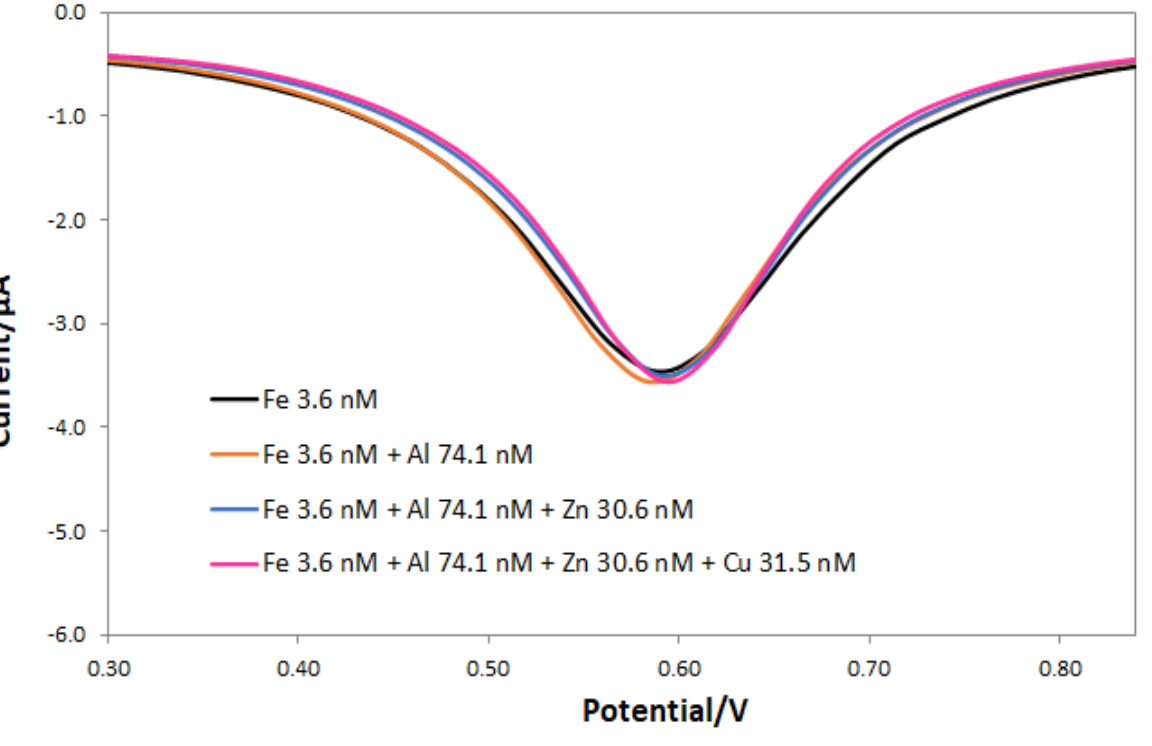
Figure 6. DPV plot obtained on the gold working electrode functionalized with DFO after immersion in 1) solution of Fe(III) 3.6 nM at pH 1 (black line), 2) solution of Fe(III) 3.6 nM and Al(III) 74.1 nM at pH 1 (orange line), 3) solution of Fe(III) 3.6 nM, Al(III) 74.1 nM, and Zn(II) 30.6 nM at pH 1 (blue line), 4) solution of Fe(III) 3.6 nM, Al(III) 74.1 nM, Zn 30.6 nM and Cu(II) 31.5 nM at pH 1 (pink line); DPV measurements were performed in 0.1M acetate buffer at pH 3.5 containing 0.1M NaClO 4 as a supporting electrolyte. Electrochemical conditions were: start potential +0.9 V, end potential -0.1 V, scan rate 100 mV/s, pulse amplitude 50 mV, pulse time 0.04 s. Table 3. Cations’ content of the simulated tap water sample without iron(III).